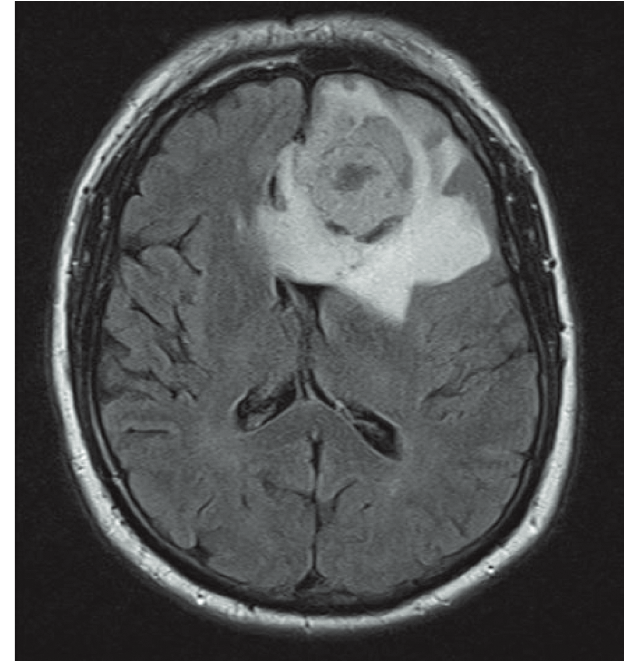
Fig. 1a. T1 axial post-contrast view shows marked peripheral contrast enhancement and central breakdown.